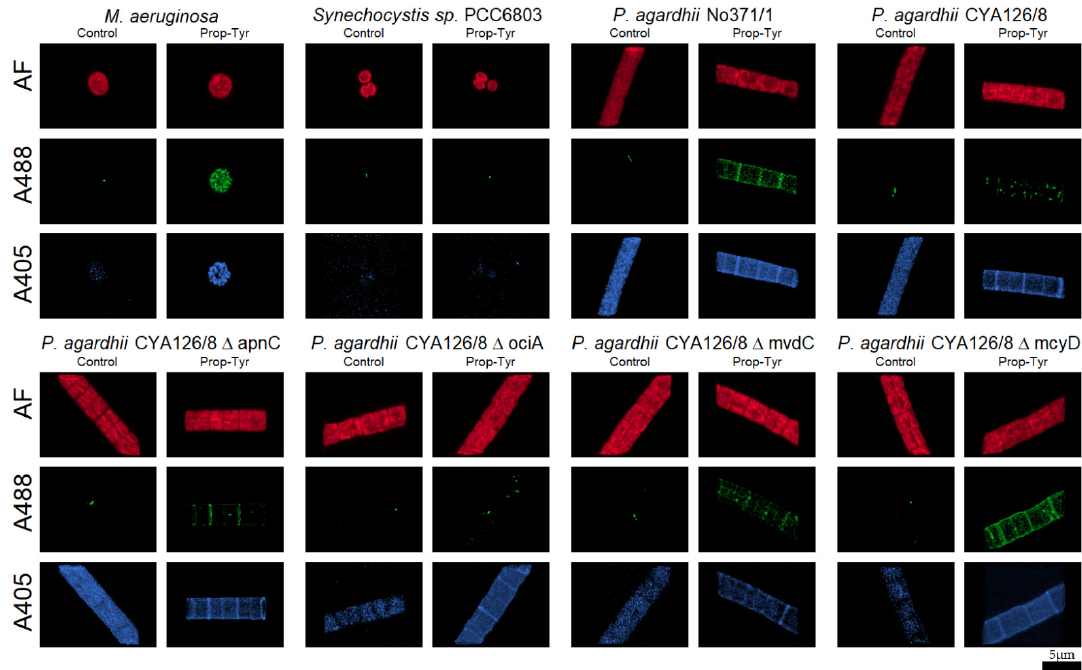
Figure 2. Confocal microscopy images from cells with labeled Prop-Tyr modified MC ( M. aeruginosa ) or AP ( P. agardhii No371/1 and CYA126/8 and peptide knock out mutants). Synechocystis PCC6803 (lacking NRPS) was used as an additional control. Cells were grown in the presence of Prop-Tyr and labeled with ALEXA488 (A488) and ALEXA405 (A405), while AF indicates autofluorescence. The respective microscopic images for Phe-Az (Figure S2), Prop-Lys (Figure S3) and a comparison between all the treatments (Figure S4) are shown in the Supplementary